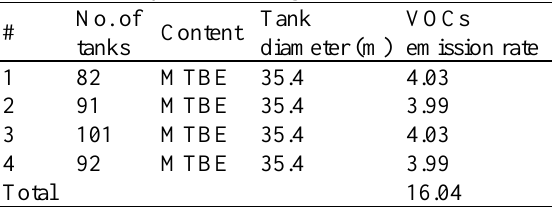
Table 2. Aggregate emission rate of internal floating roof tanks (ton/year) with height of 10